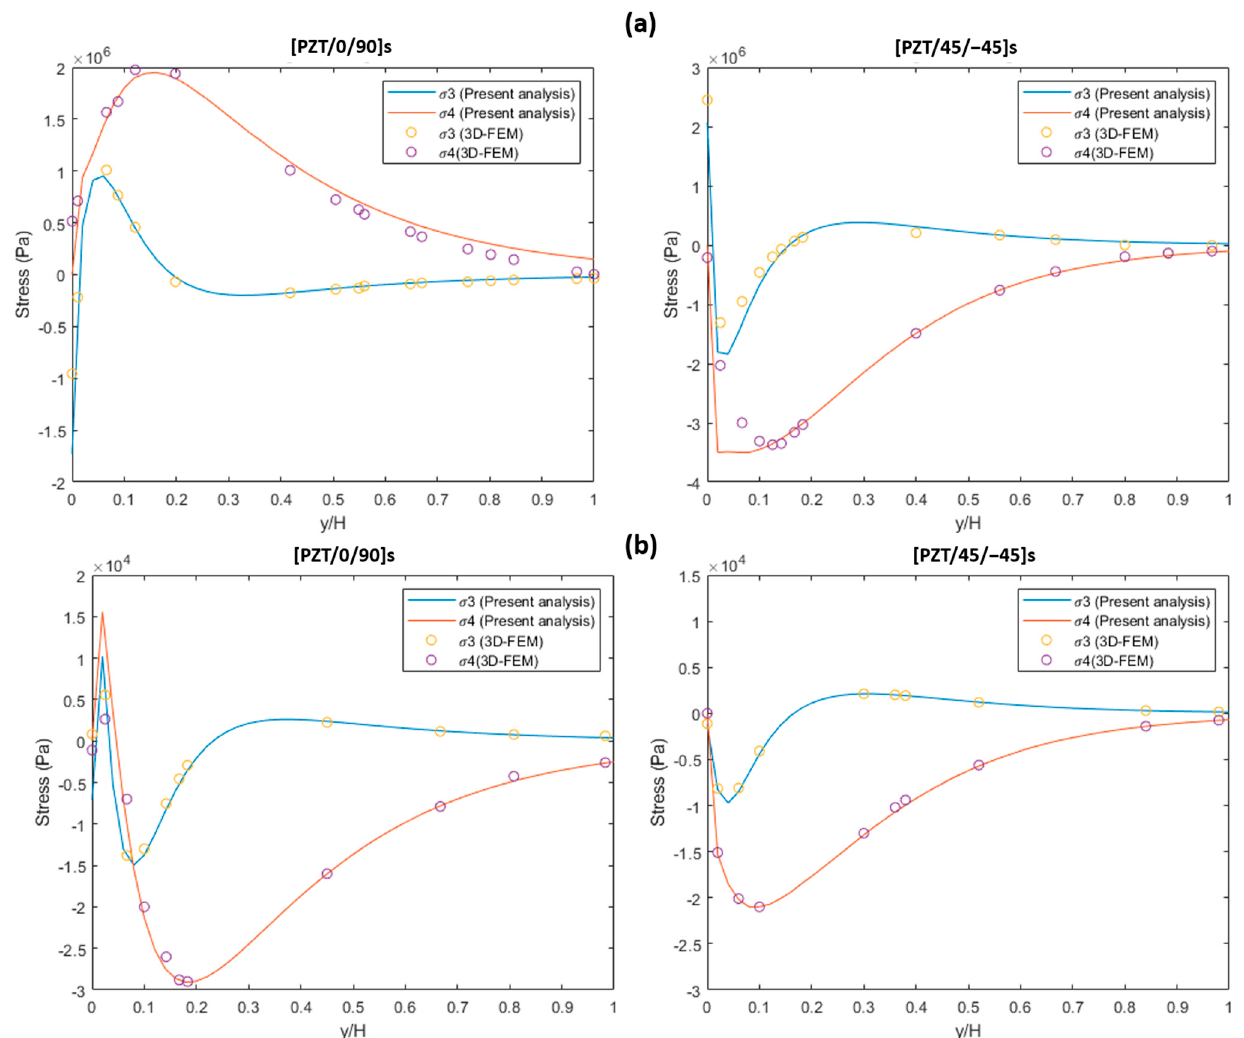
Figure 4. Normal stress σ 3 and shear stress σ 4 at the PZT/0 and PZT/45 interface of [PZT/0/90] s and [PZT/45/ − 45] s composite laminates ( a ) under 0.1% uniaxial extension and ( b ) laminates under unit thermal loading ( Δ T = 1).